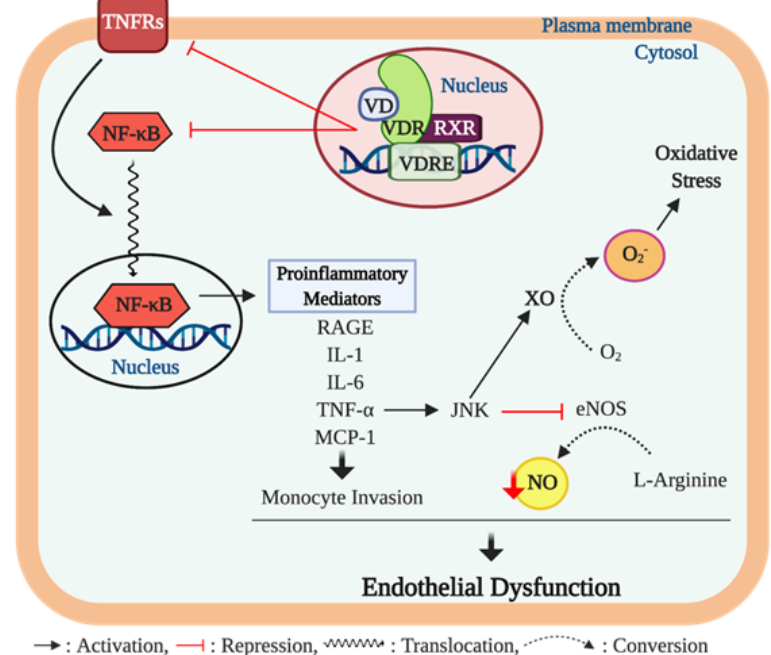
Figure 4. Vitamin D, inflammation, and endothelial dysfunction. The chronic inflammation process contributes to developing endothelial dysfunction through proinflammatory cytokine activity. Ligand bound vitamin D receptor (VDR) activation suppresses gene expression of nuclear factor ‐κ B